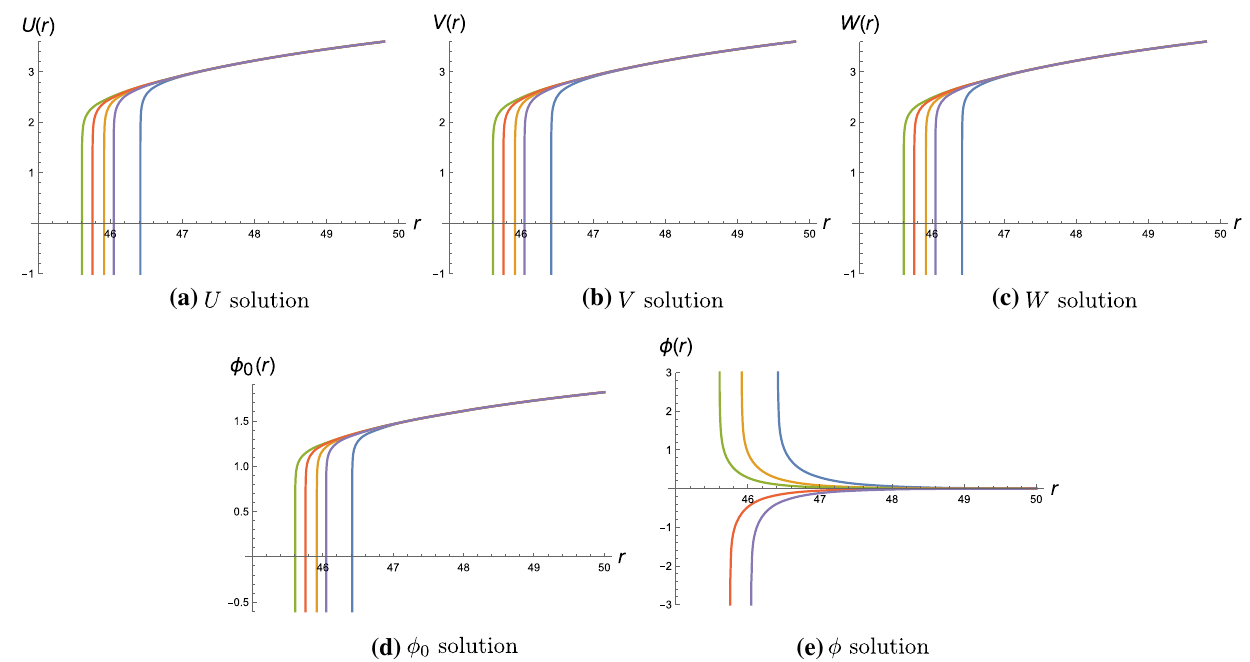
Fig. 38 Supersymmetric flows interpolating between asymptotically locally flat domain walls and Mk w 2 × S 2 × S 2 -sliced curved domain walls in SO ( 4 ) gauge group. The blue, orange, green, red and purple curves refer to p 21 = − 0 . 5 , − 0 . 12 , 0 , 0 . 12 , 0 . 25, respectively